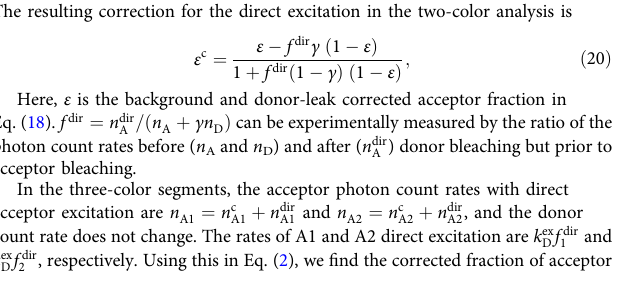
〈 r 2 〉 and 〈 r 2 〉 are obtained by fi tting the experimental FRET ef fi ciencies E 2c 1 2 E 2c 2 from the two-color segments to Eq. (24) and 〈 r 12 2 〉 is found as 〈 r 2 2 〉 − 〈 r 1 2 〉 . When the alternating excitation is used, 〈 r 12 2 〉 can also be determined from the two-color FRET ef fi ciency E 12 by A1 excitation. The three-color FRET ef fi ciencies due to the Gaussian chain model are